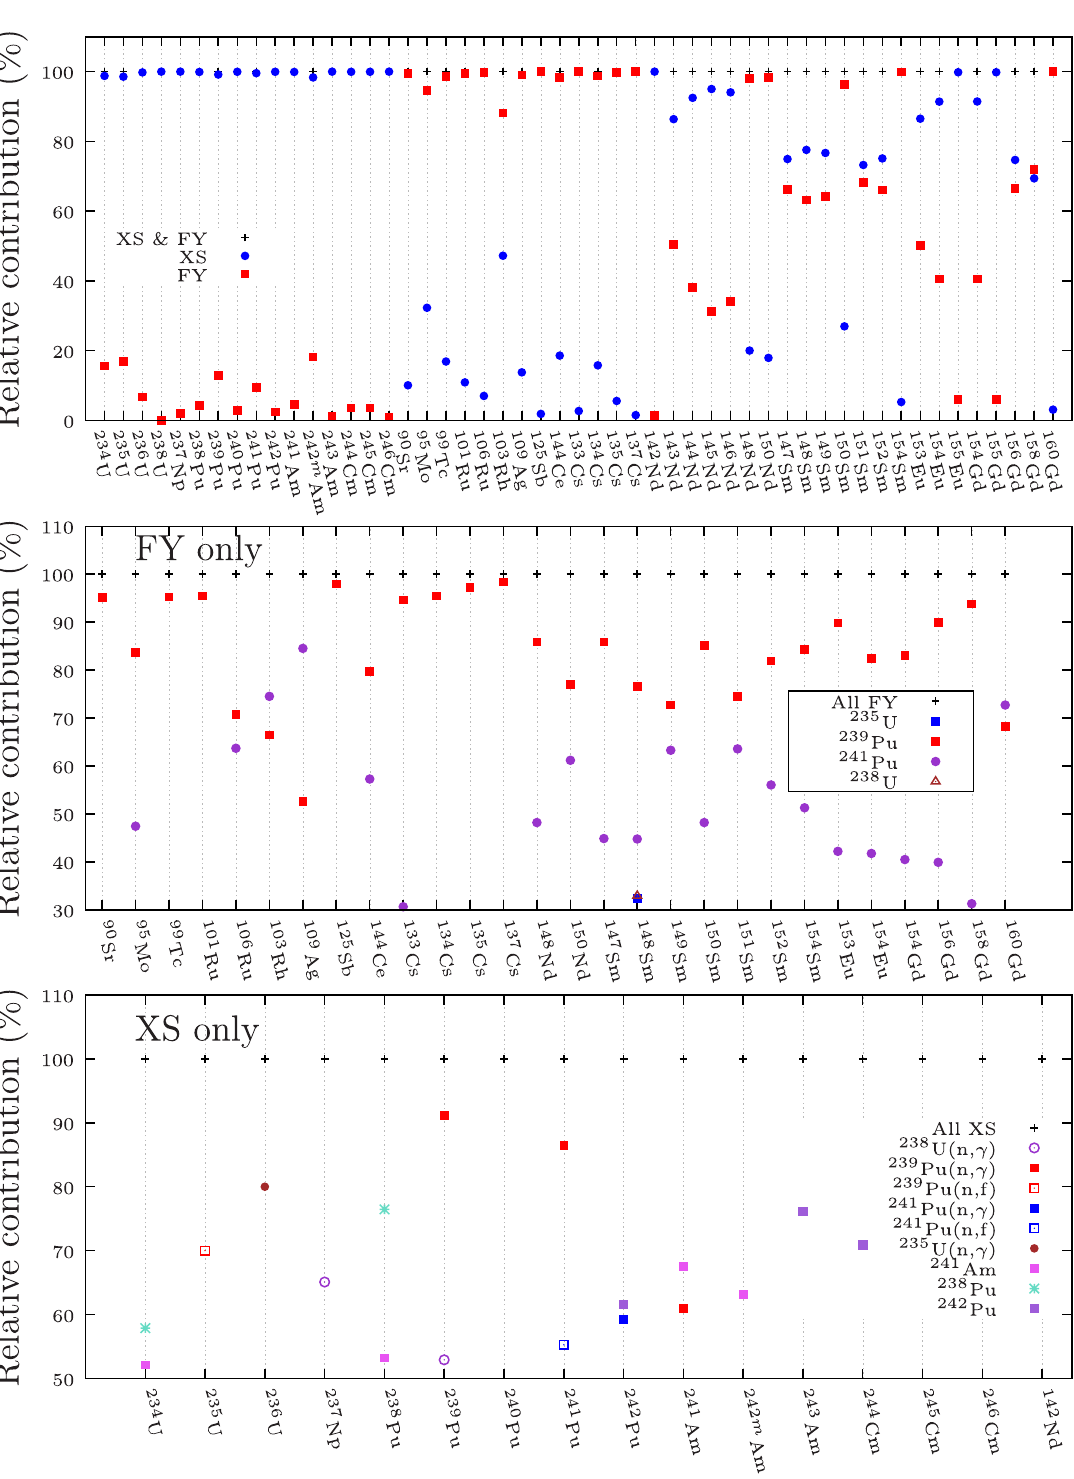
Fig. 5. Relative contributions of the cross sections (called XS) and fission yields (called FY) to the total uncertainties. For XS and FY, the main contributors are also